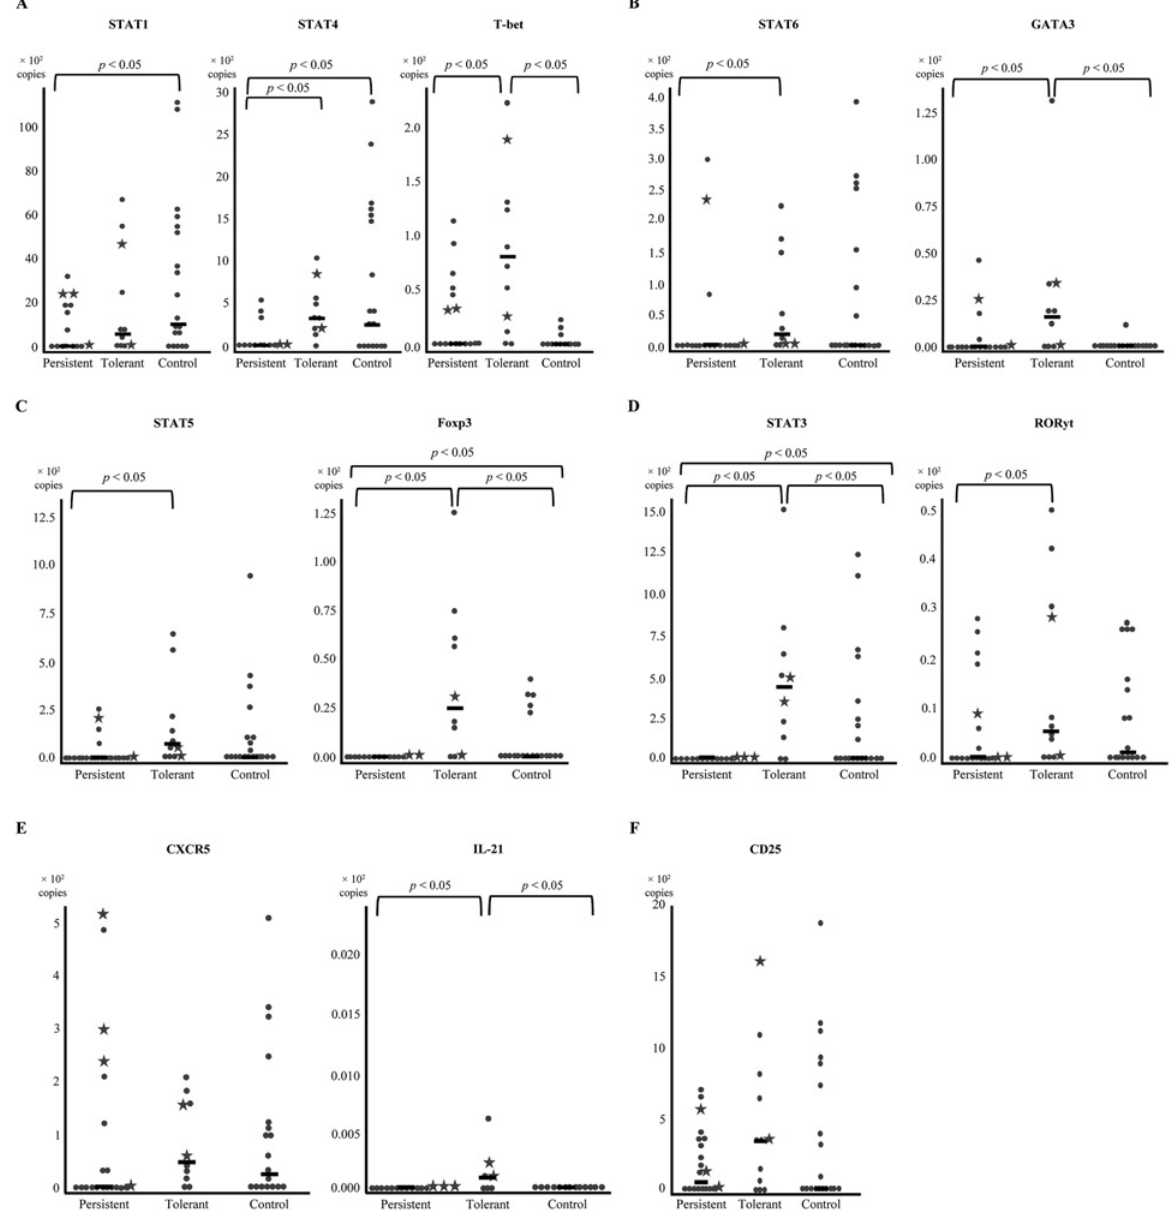
Figure 1. mRNA expression of effector T cells responded to ovalbumin. Comparison of PBMC subclasses related to circulating effector CD4 + cells stimulated in vitro by ov- albumin among egg allergy persistent, tolerant, and control groups. The vertical axis represents the number of copies per 50 ng of RNA. The parameters are representative of Th1 ( A ), Th2 ( B ), Treg ( C ), Th17 ( D ), Tfh ( E ) and Tfr ( F ) type immune responses. Foxp3 and CXCR5 are also involved in the Tfr phenotype. The data for patients with a history of resolved anaphylaxis to egg white protein are plotted with a ★